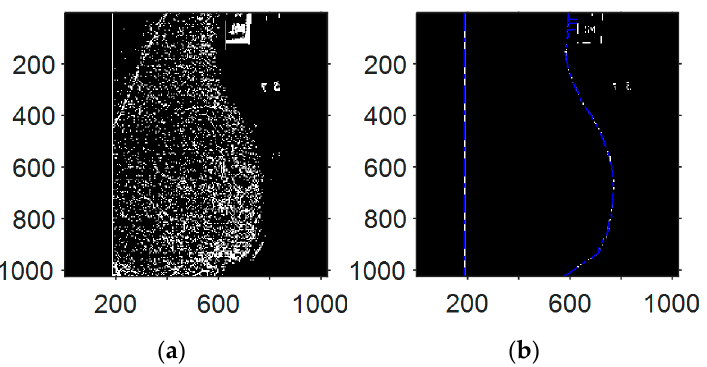
Figure 2. Detection of the outer edges of the breast (region 2) ( a ) after applying the operator on the original grey scale mammogram and ( b ) after applying the operator on the black and white mammogram.